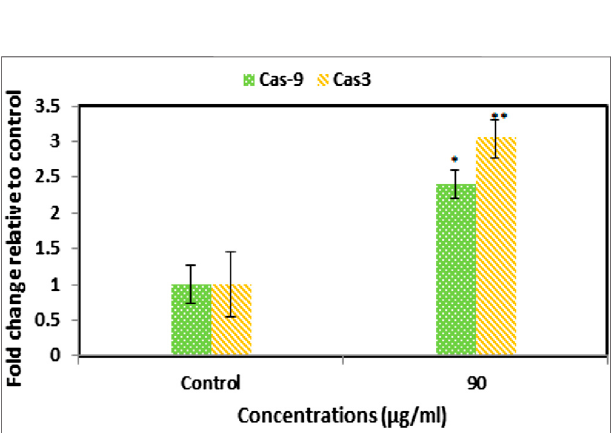
FIGURE 6 | Increased expression of caspase 3 and 9 genes in SEO- SCF-NPs-treated cellsbytheqPCRmethod. Theresultswererepresented as mean ± SD and “ * ” p < 0.05 and “ ** ” p < 0.01.